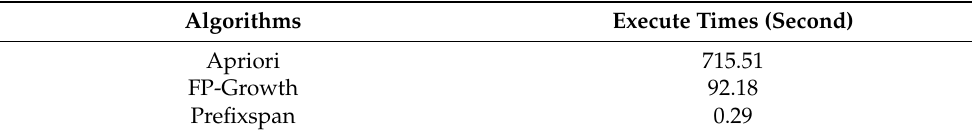
Table 13. Comparison of the execution time of Apriori, FP-Growth, and Prefixspan.